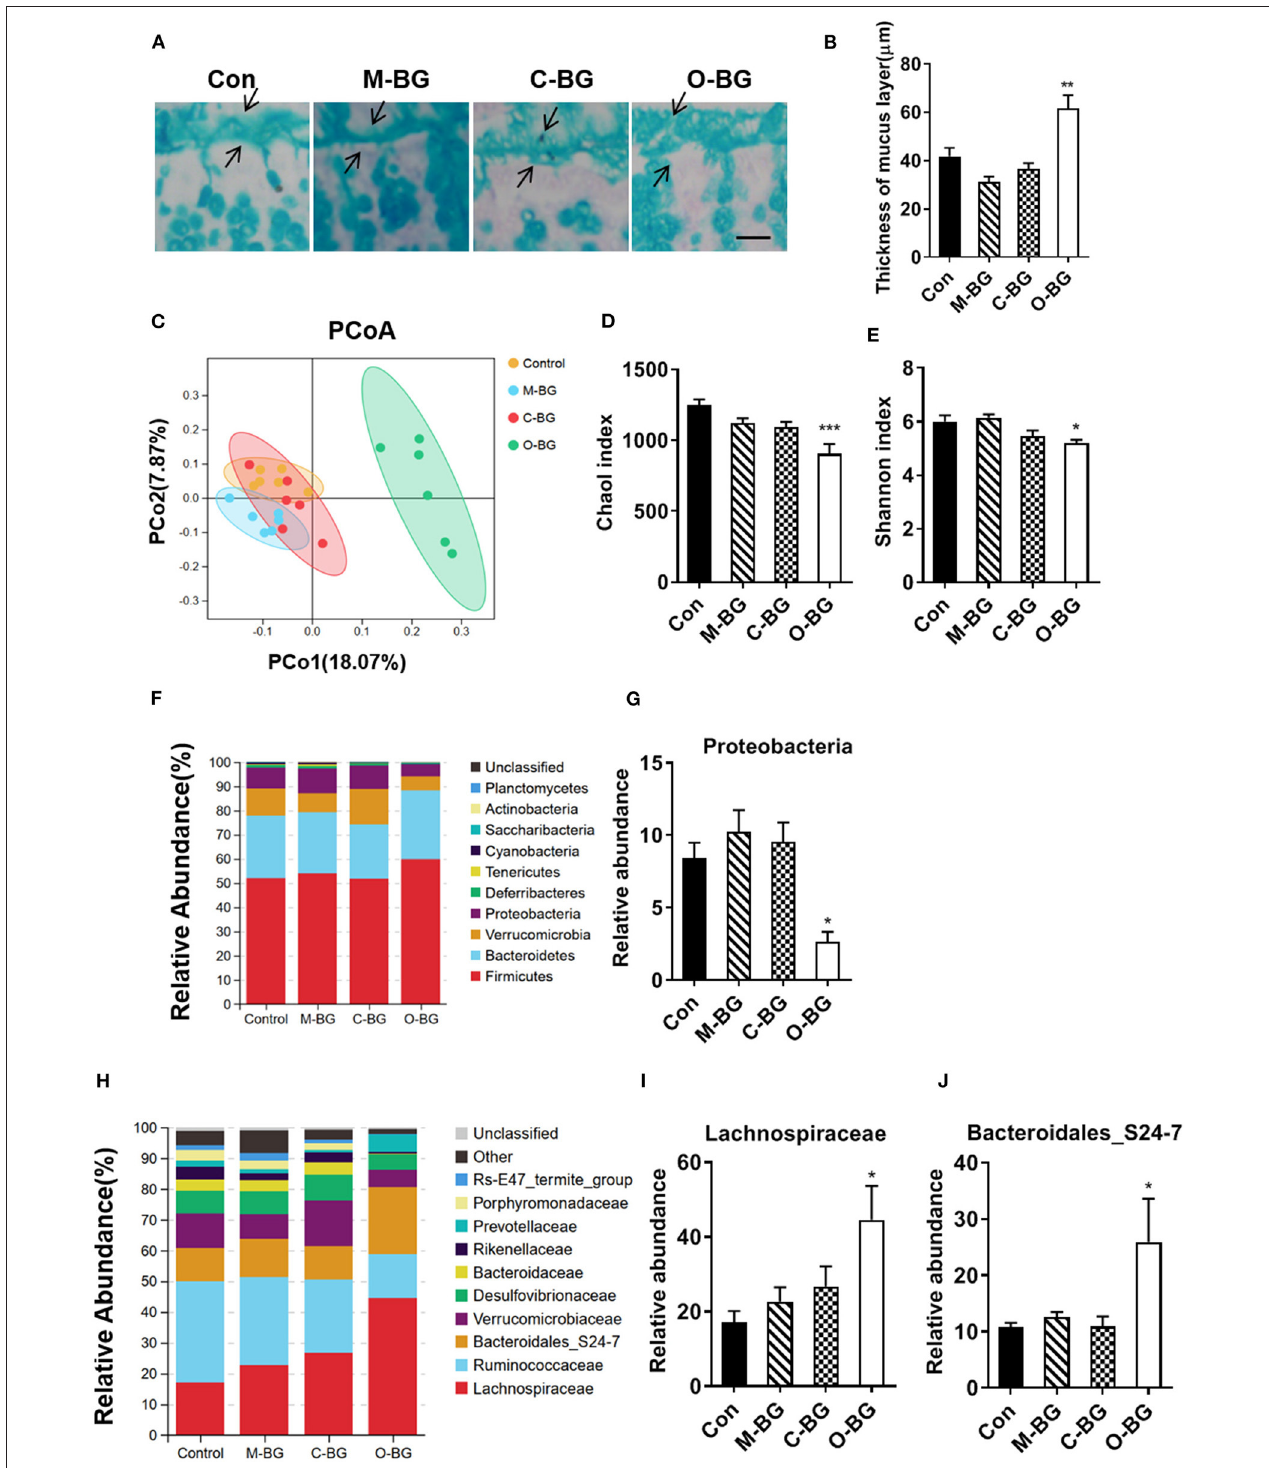
FIGURE 4 | β -glucans had different effects on gut microbiota. (A,B) Alcian blue staining for colon and quantification of colonic mucus layer thickness, n = 6. (C) Principal coordinates analysis plot of unweighted UniFrac distances, n = 6. (D) Richness (Chao1 index) of gut microbial communities, n = 6. (E) Diversity (Shannon index) of gut microbial communities, n = 6. (F) The relative abundance of bacteria at the phylum level, n = 6. (G) Relative abundance of Proteobacteria, n = 5–6. (H) The relative abundance of bacteria at the family level, n = 6. (I,J) Relative abundance of Lachnospiraceae and Bacteroidales_S24-7 families, n = 5–6. Data were presented as mean ± SEM. * P < 0.05 vs. Control, ** P < 0.01 vs. Control, *** P < 0.001 vs. Control. Scale bar: 80 µ m.